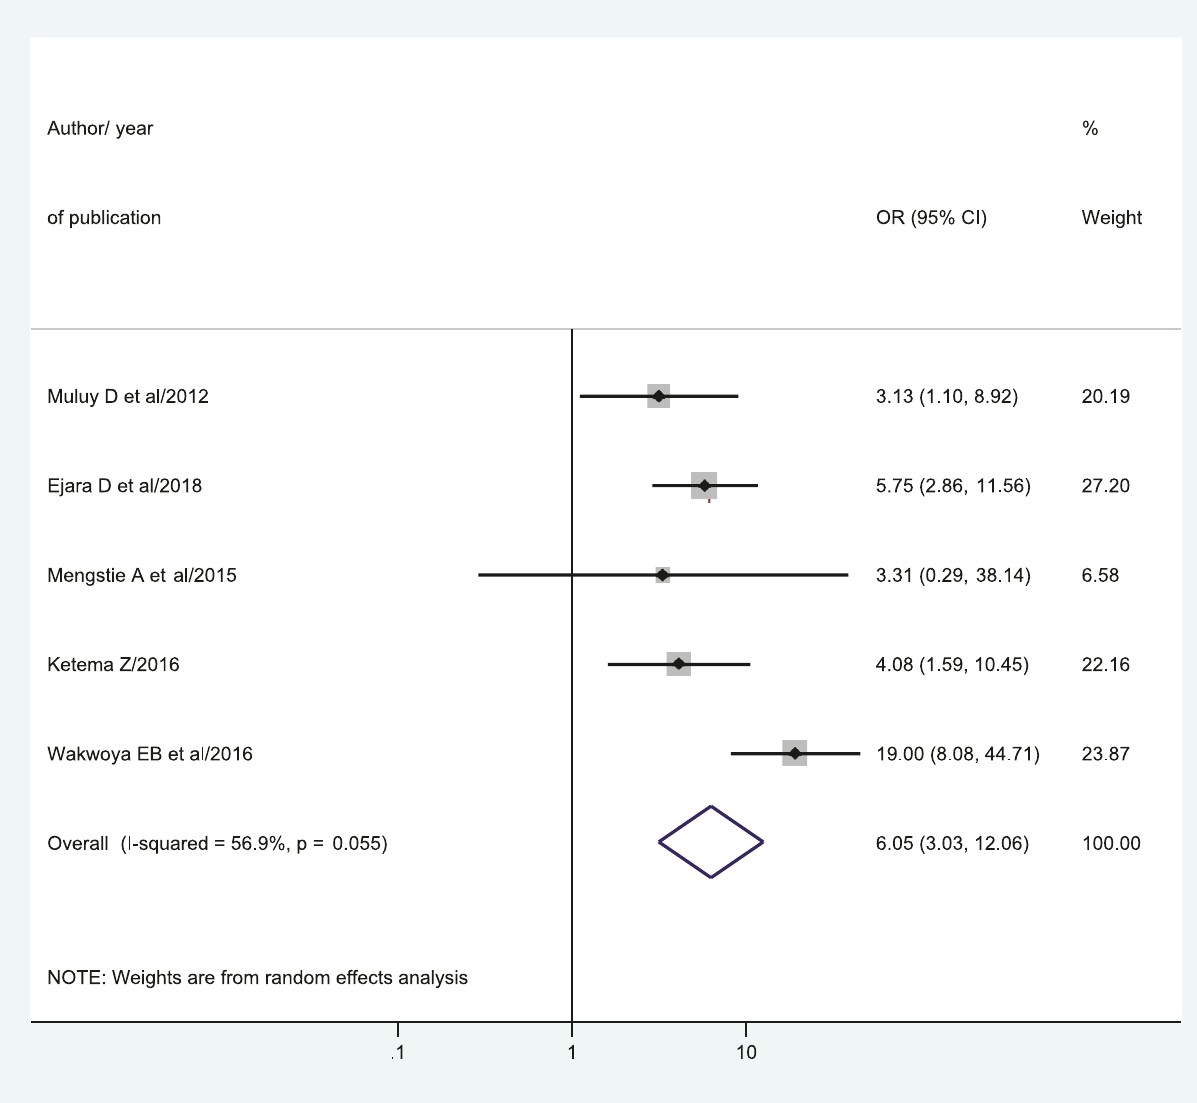
Figure 6: Forest plot of odds ratio of HIV disclosure status to the spouse with 95% CI. The midpoint and the length of each segment showed OR and 95% CI, respectively. The diamond shape revealed pooled